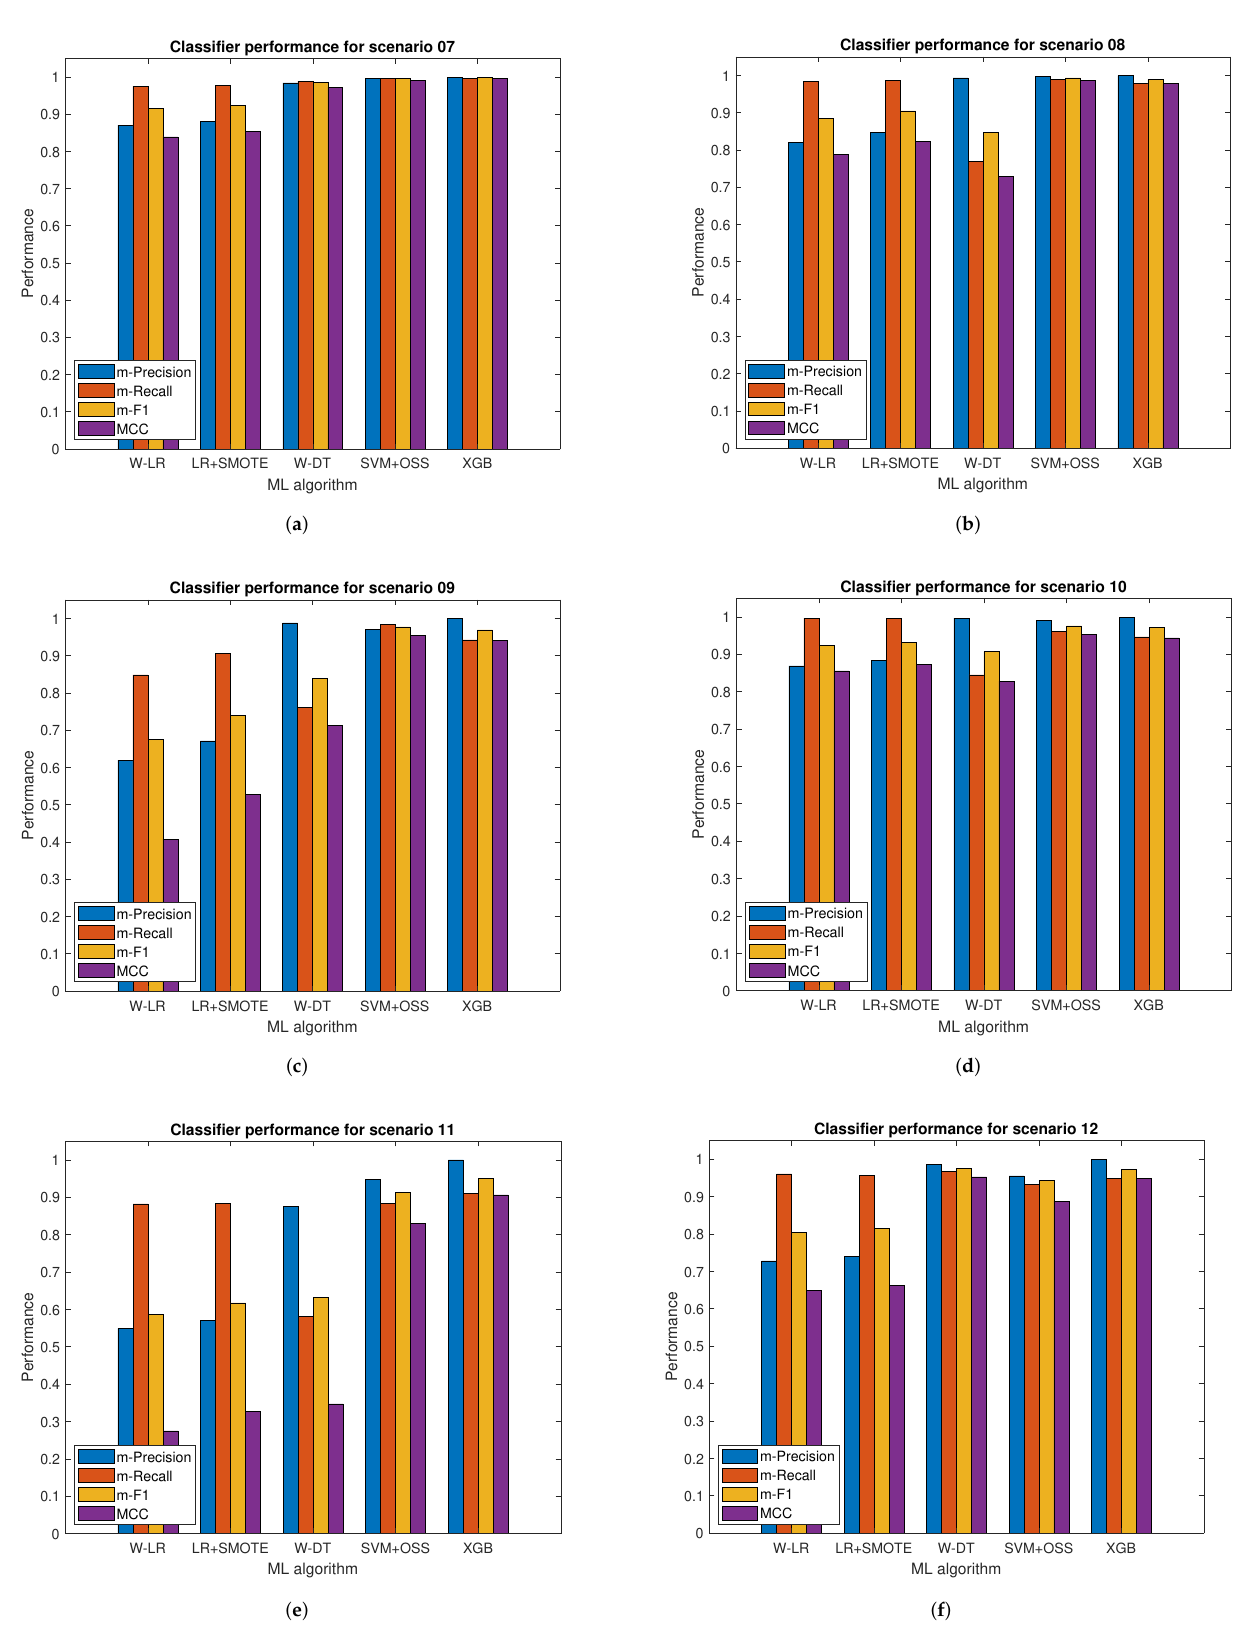
Figure 6. Classifiers performance in botnet attacks detection for scenarios 7 to 12. ( a ) Scenario 7. ( b ) Scenario 8. ( c ) Scenario 9. ( d ) Scenario 10. ( e ) Scenario 11. ( f ) Scenario